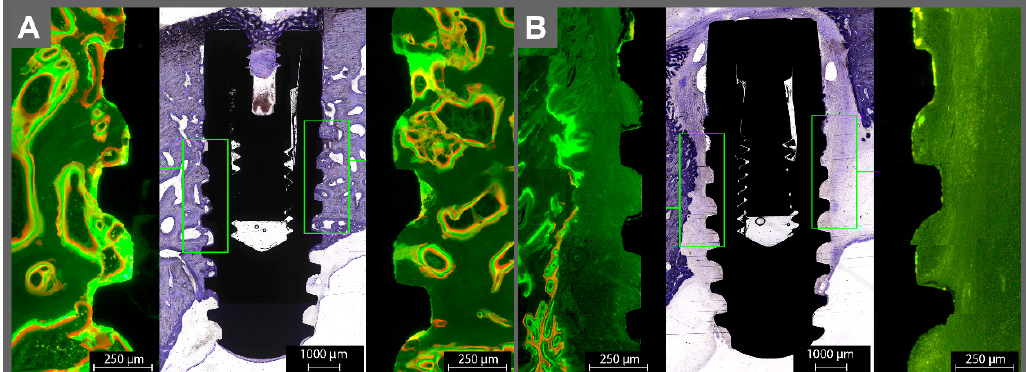
Figure 3. The histological examination of the ( A ) sterile and ( B ) contaminated implant in the frontal bone. Please note the lack of osseointegration around the contaminated implant. Around the sterile implant, the green and red fluorophores were overlapping and surrounding the implant without gaps, indicating healthy bone growth on the implant surface. Orange fluorescence was found on bone trabecula. Around the infected implants, almost no fluorescence was found on the surface, except in some areas with a very thin line of green fluorescence.